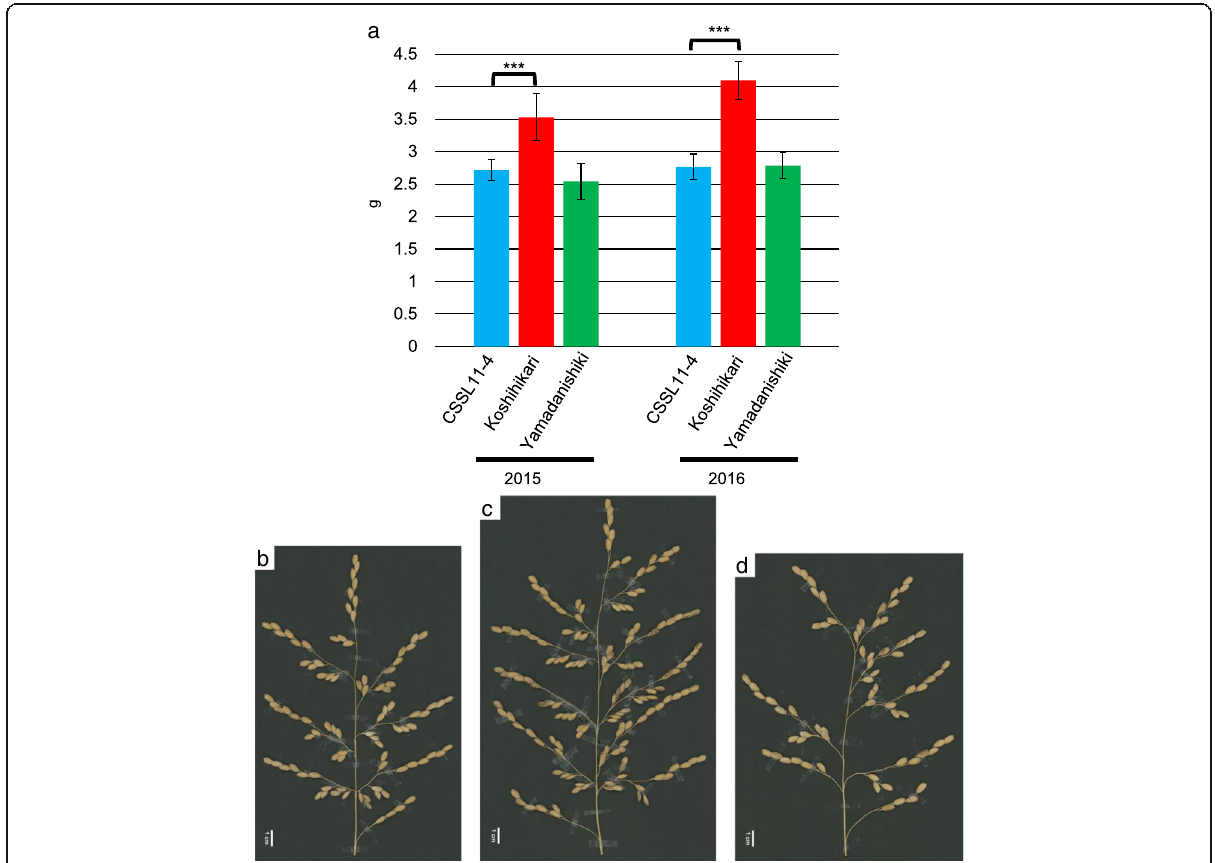
Fig. 3 One panicle weights measured in CSSL11 – 4, Koshihikari, and Yamadanishiki ( a ) and panicles of CSSL11 – 4 ( b ), Koshihikari ( c ), and Yamadanishiki ( d ). *** represents a significant difference at P <